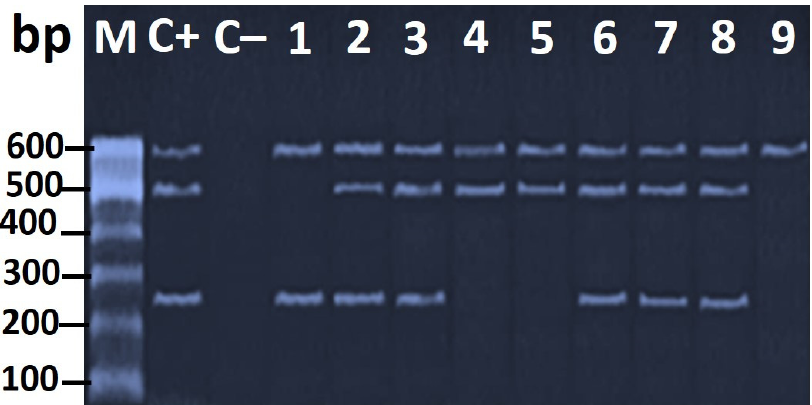
Figure 5. Agarose gel electrophoresis of the multiplex PCR of vacA (259 bp), cagA (499 bp), and hrgA (594 bp) as virulence genes of H. pylori strains. Lane M: 100 bp ladder as a molecular-size DNA marker. Lane C+: H. pylori ATCC 43504 strain positive control. Lane C − : E . coli K12 DH5 α negative control. Lanes 2, 3, 6, 7, and 8: H. pylori positive control for vacA , cagA , and hrgA genes. Lanes 4 and 5: positive control of H. pylori for cagA and hrgA genes. Lane 1: positive control of H. pylori for vacA and hrgA genes. Lane 9: positive control of H. pylori for the hrgA gene. Lanes 1 and 2 represent chicken meat; lanes 3 and 4 represent chicken gizzard; lanes 5 to 9 represent chicken liver.